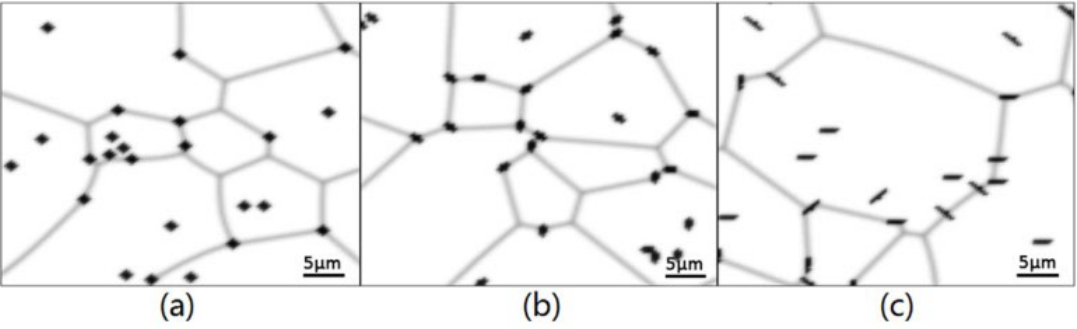
Figure 16. Simulated microstructures of AZ31 Mg alloy particles with different shape at 623K: ( a ) spherical particles, ( b ) ellipsoid particles; and ( c ) rod-shaped particles [118].